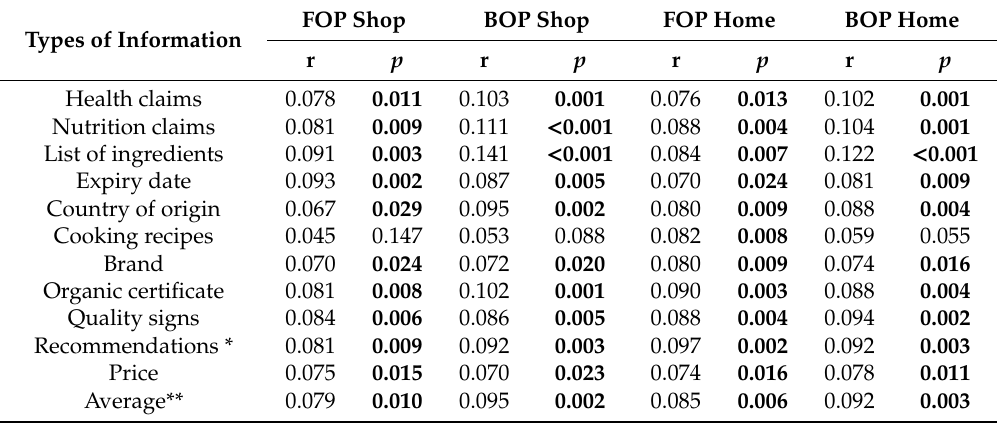
Table 12. Pearson correlation coe ffi cients of reading food labels with the subjective importance of selected information on